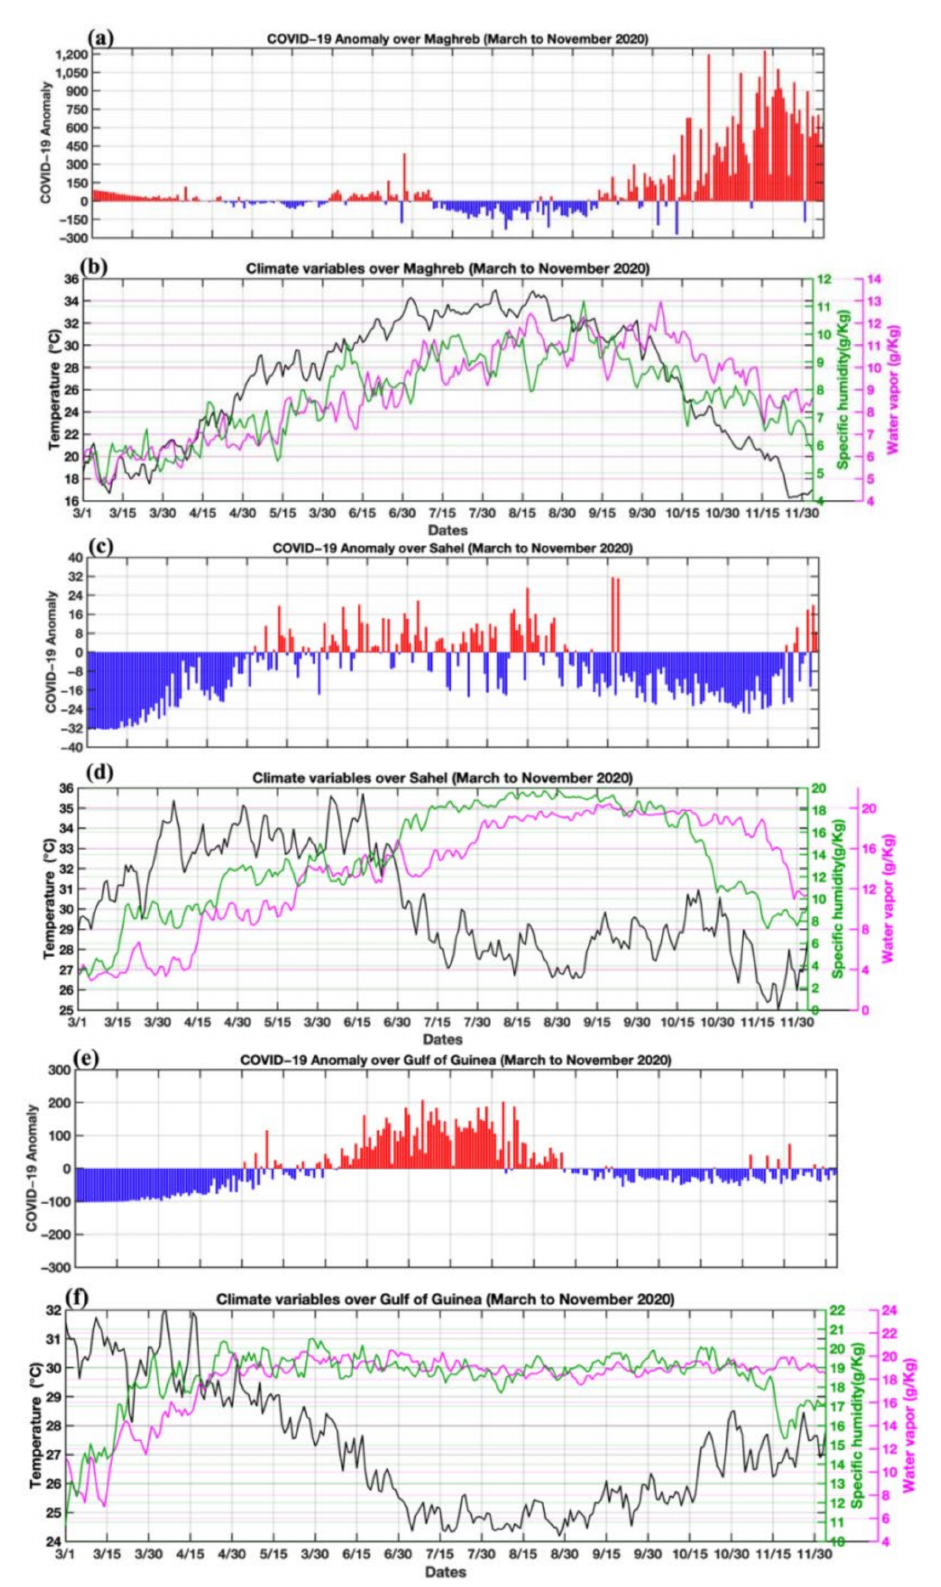
Figure 6. COVID-19 daily case anomaly (residual) and climate parameters for the period between 1 March and 30 November 2020 ( a , b ) for Maghreb, ( c , d ) for Sahel, and ( e , f ) for the Gulf of